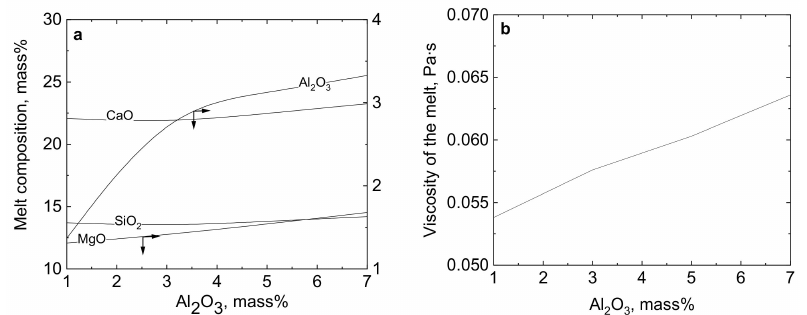
Figure 12. ( a ) Composition of the liquid melt formed at 1573 K and oxygen partial pressure of 10 − 8 atm and ( b ) the viscosity of the melt under various Al 2 O 3 content.